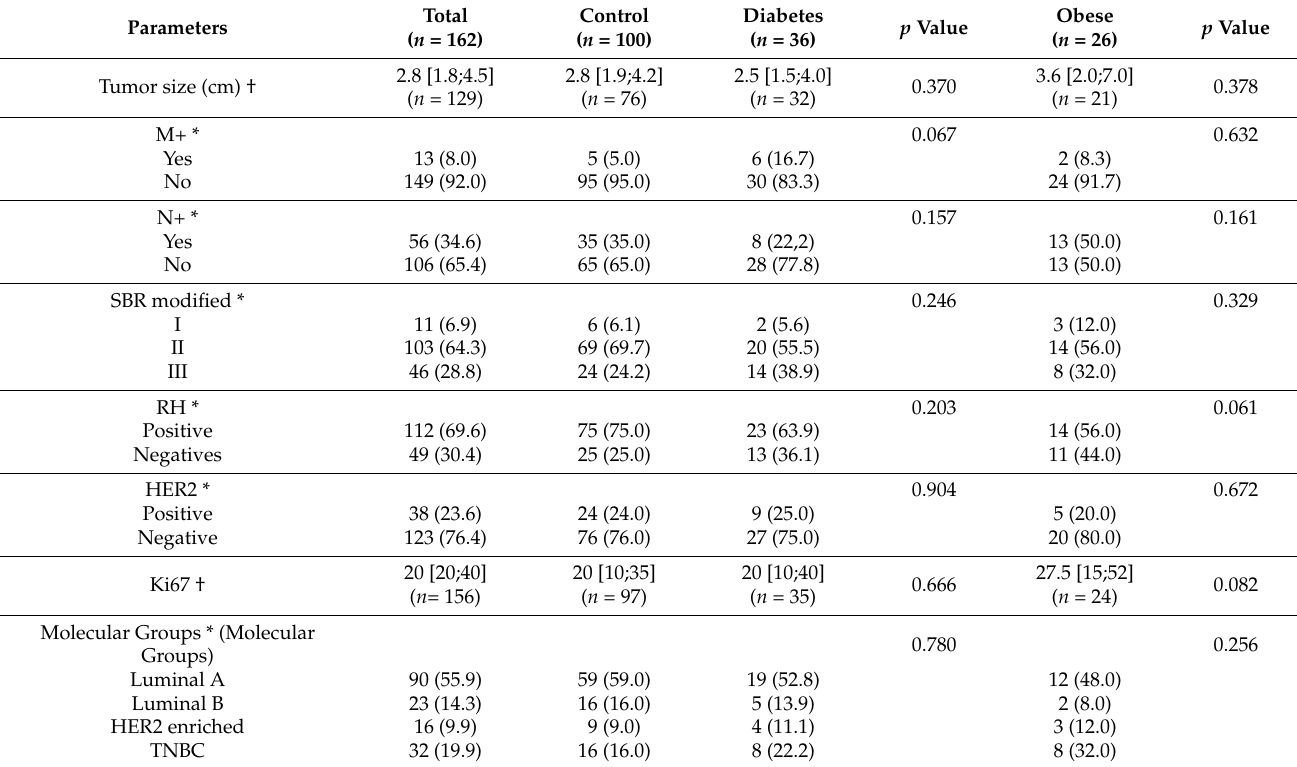
Table 5. Clinicopathological comparisons of diabetic and obese patients with the control